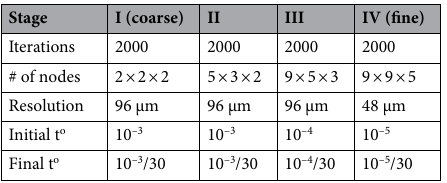
Table 1. Stages of spatial